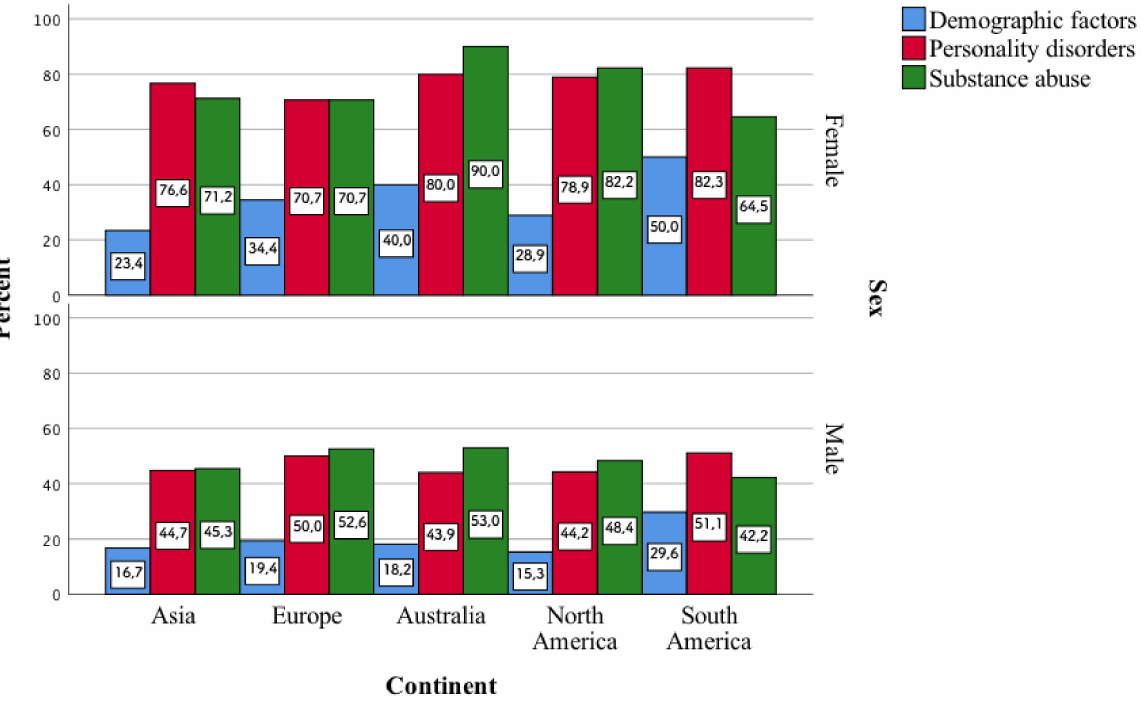
Figure 4. Demographic factors, personality disorders, and substance abuse as variables in- fluencing, according to the surveyed women and men, the occurrence of the phenomenon of